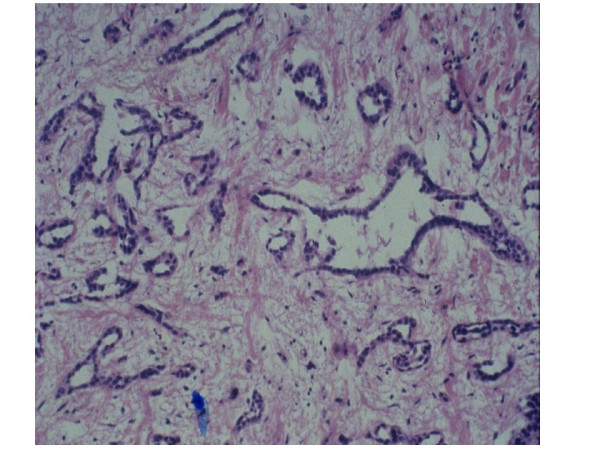
Malignant pleural mesothelioma of epithelial type. Epithelial MPM derives from the mesothelial cells and consists of glands and tubules that resemble adenocarcinoma. Large spherical cells are arranged in solid masses and columns mostly within lymphatics. There may also be glandular formation as demonstrated in this photograph. (Personal photo of Neragi-Mianoab).